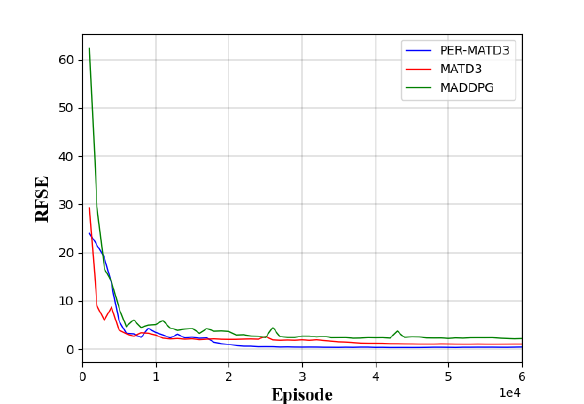
Figure 9. Formation stability error